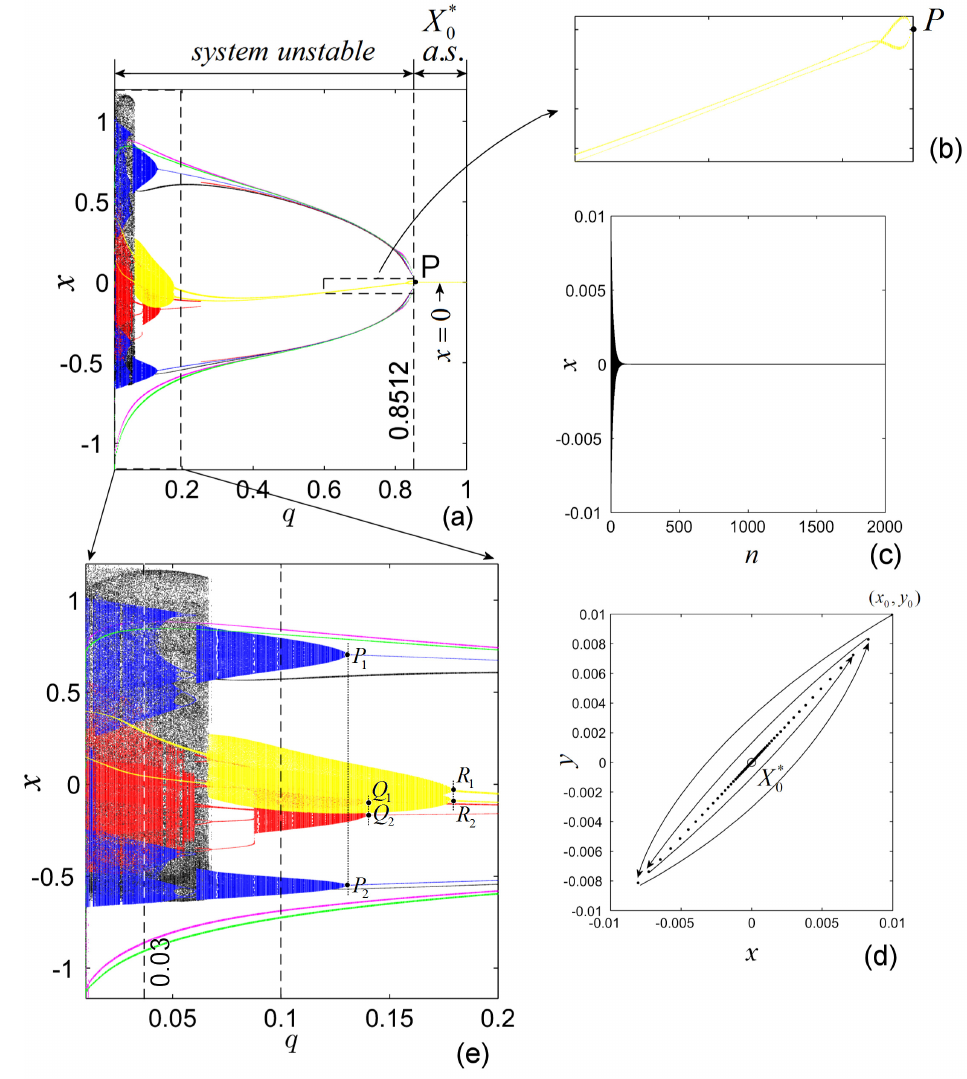
Figure 3. DLM of FO. ( a ) Bifurcation diagram vs. q . The bifurcation-like point P indicates the beginning of the stability of X ∗ for q > 0.8512; ( b ) zoomed image; ( c ) time series tending to the 0 asymptotically stable fixed point X ∗ for q > 0.8512; ( d ) phase portrait with the orbit points indicating 0 the evolution of the orbit to X ∗ ; ( e ) zoomed area of the bifurcation 0